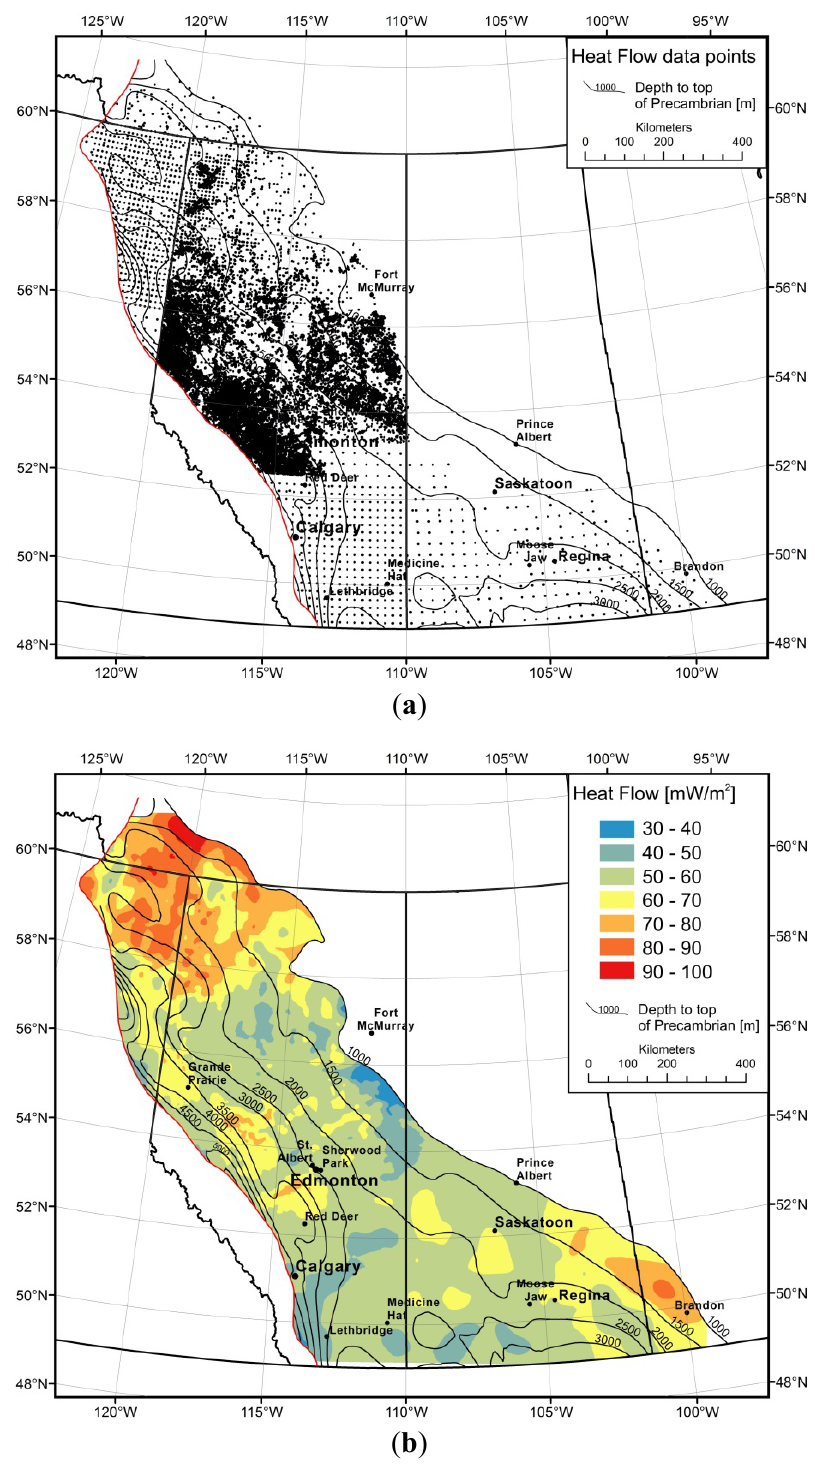
Figure 3. ( a ) Data points used for mapping of heat flow; dataset consists of on 74,728 values at 26,421 locations; ( b ) Heat flow of the WCSB; map was calculated using the simple kriging